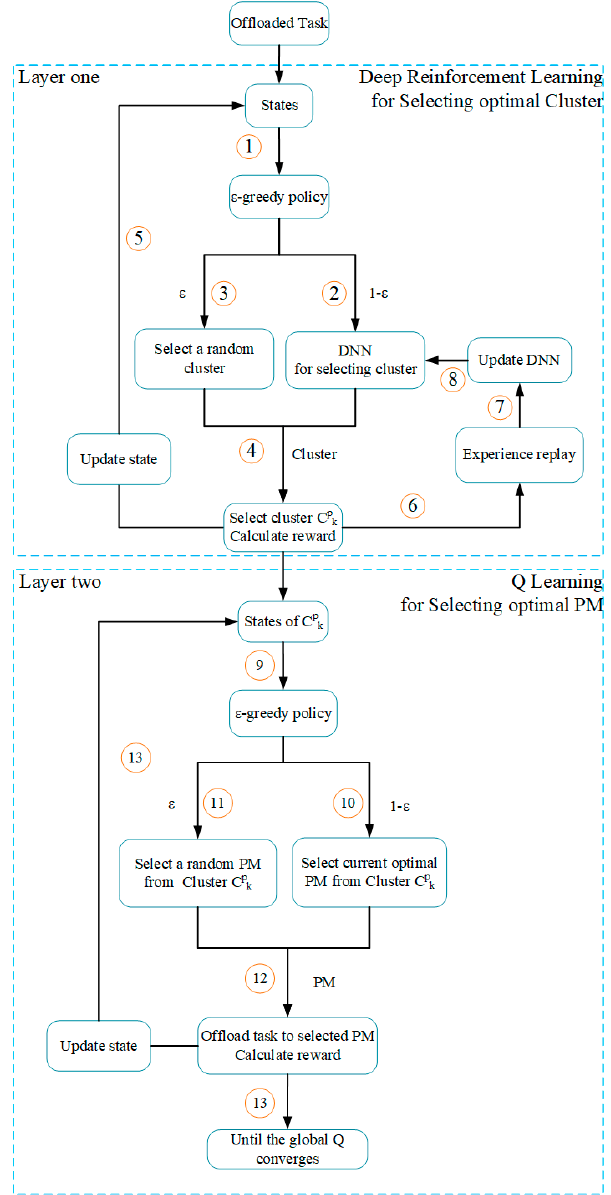
Figure 7. Flow diagram of task offloading algorithm based on TLRL.